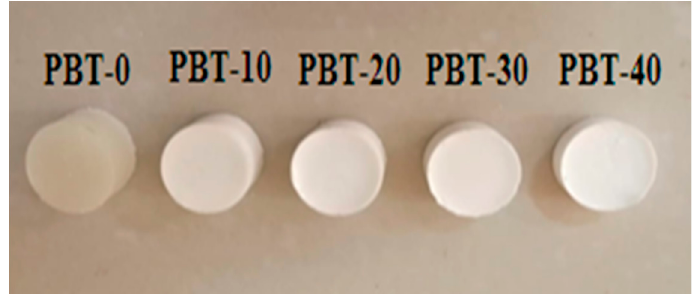
Figure 1. The prepared study samples.